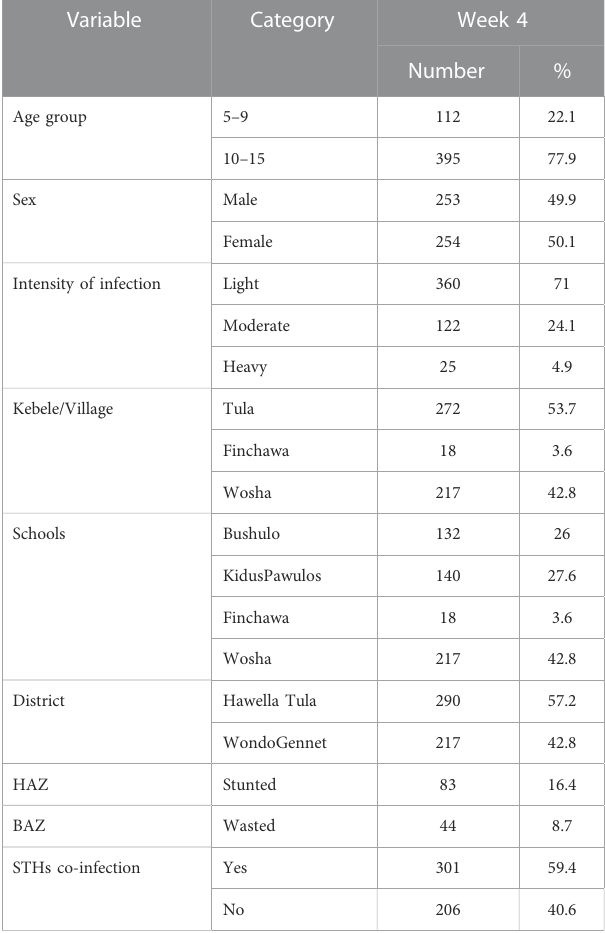
TABLE 1 Baseline socio-demographic characteristics of study